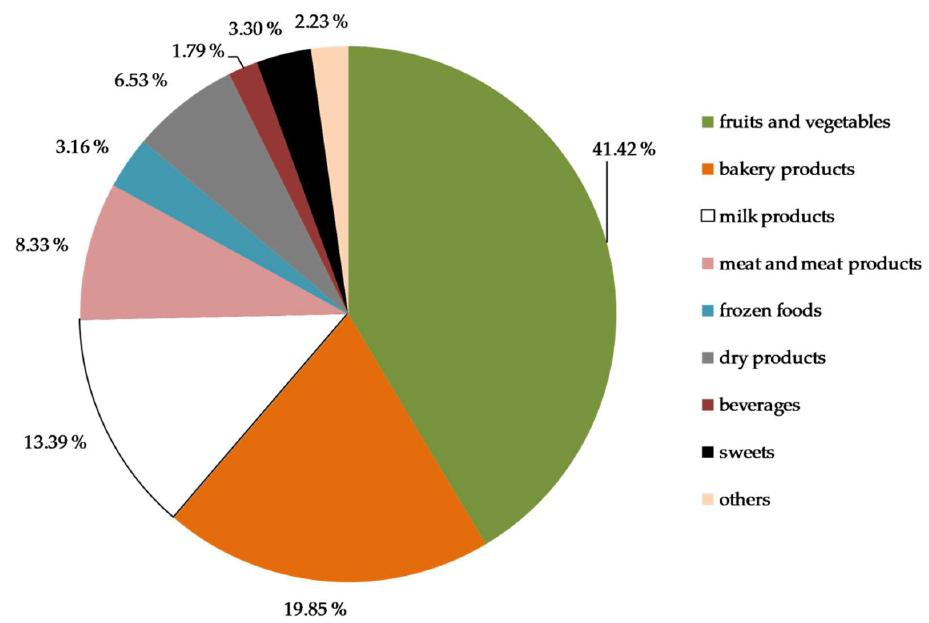
Figure 5. Categories of food distributed by participating food banks in percent, 2017.